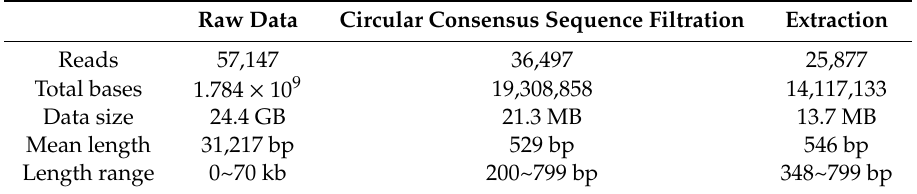
Table 2. Processing information for library A’s data generated by SMRT